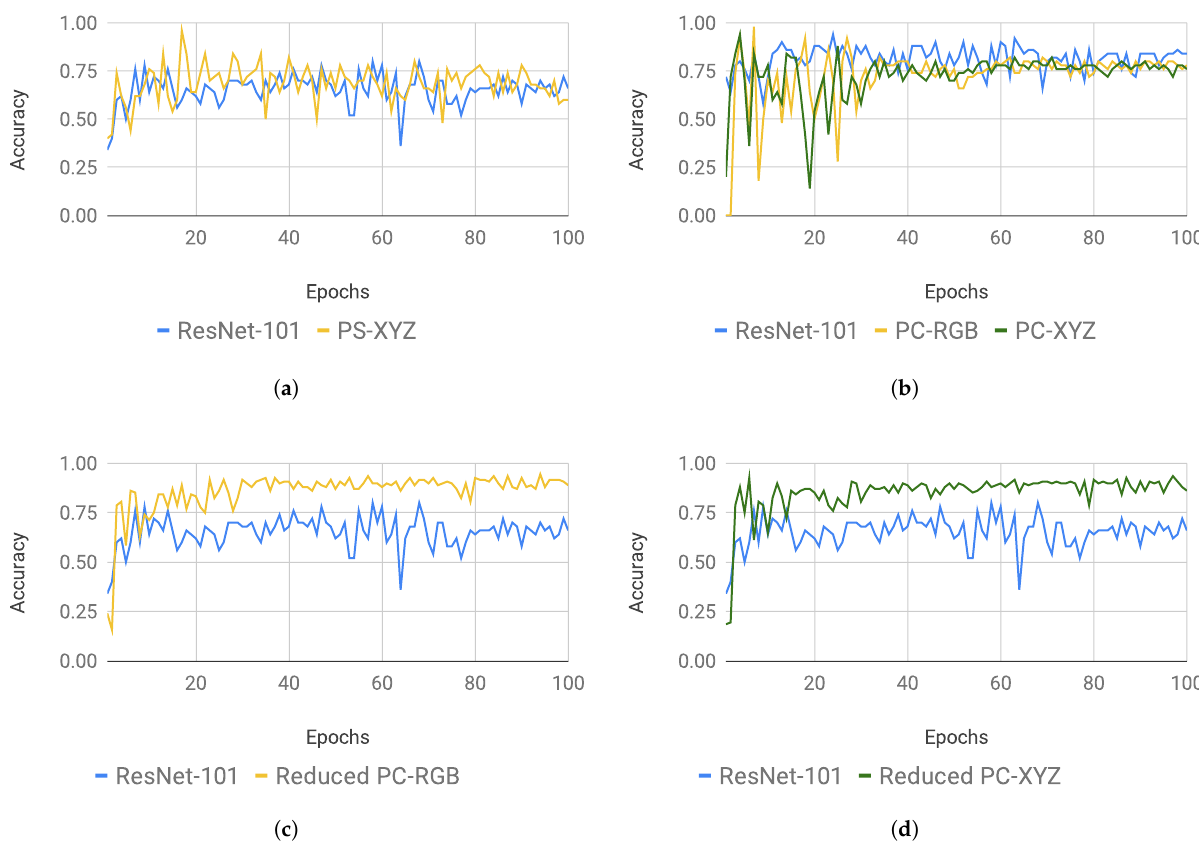
Figure 10. The accuracy curves of ResNet-101, PS-RGB, and Reduced ALL plotted versus training epoch on each of the 7 classes in the testing set. ( a ) Class 1 (melanoma, MEL). ( b ) Class 2 (melanocytic nevus, NV). ( c ) Class 3 (basal cell carcinoma, BCC). ( d ) Class 4 (actinic keratosis, AKIEC). ( e ) Class 5 (benign keratosis, BKL). ( f ) Class 6 (dermatofibroma, DF). ( g ) Class 7 (vascular lesion, VASC).